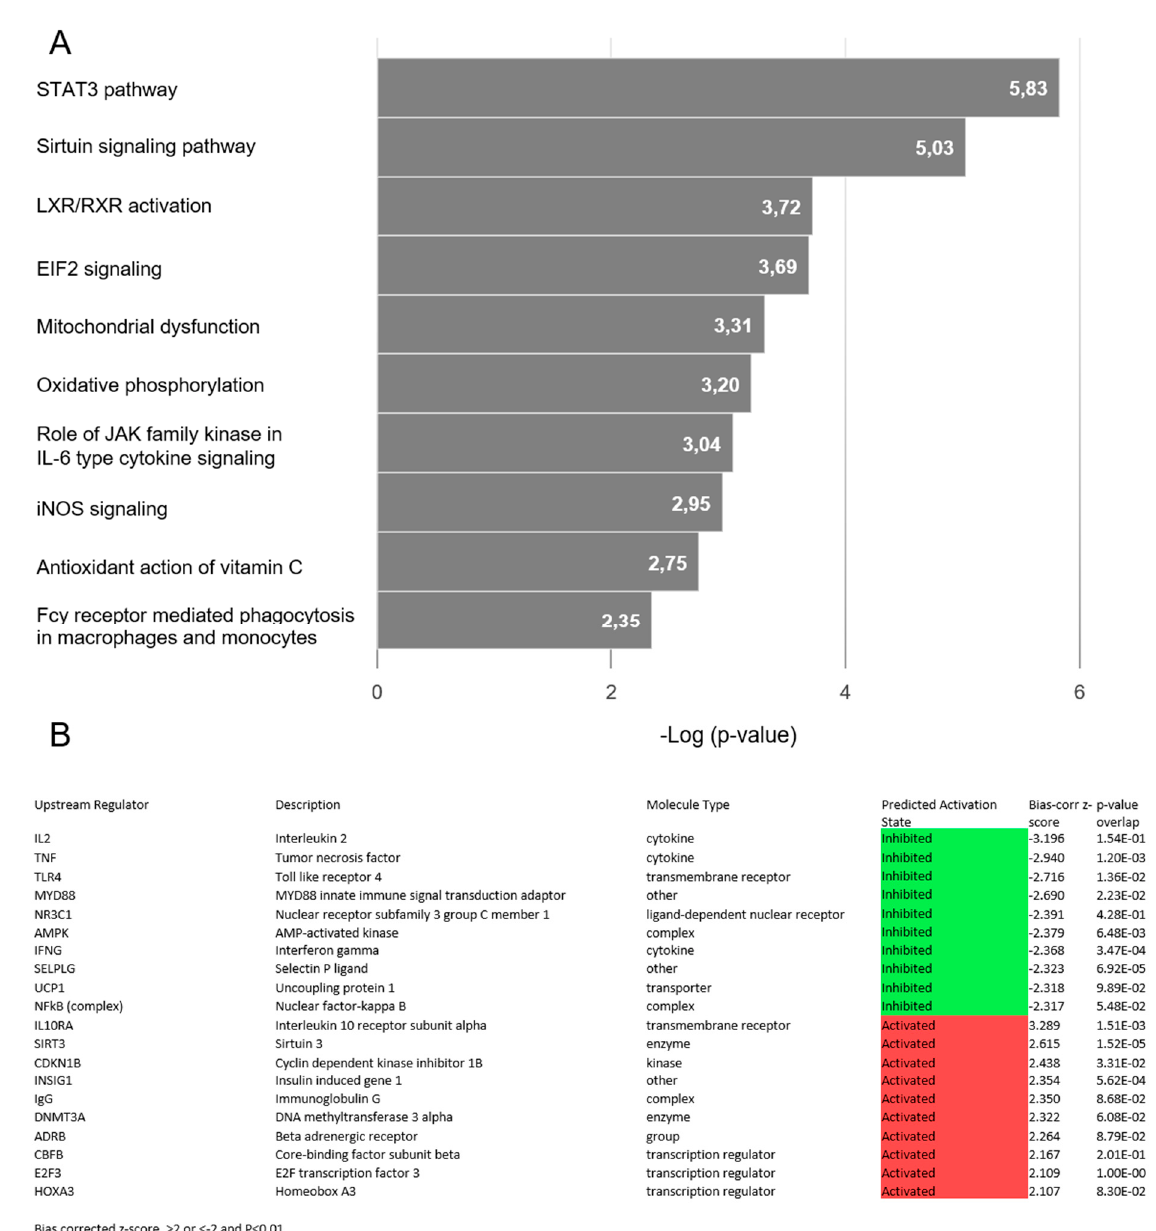
Figure 3. Expression analysis of RNA-seq data. ( A ) Graph depicting the top 10 canonical pathways ( p -value < 0.01) derived from an IPA analysis based on differentially expressed genes (fold change ≥ 1.5 and false discovery rate adjusted p -value < 0.05) in aortic samples from MFS patients compared to controls. ( B ) Table depicting predicted activation or inhibition of key upstream transcriptional regulators (bias-corrected z-score >2 or < − 2, p -value < 0.01) derived from an IPA analysis based on the observed gene expression changes.